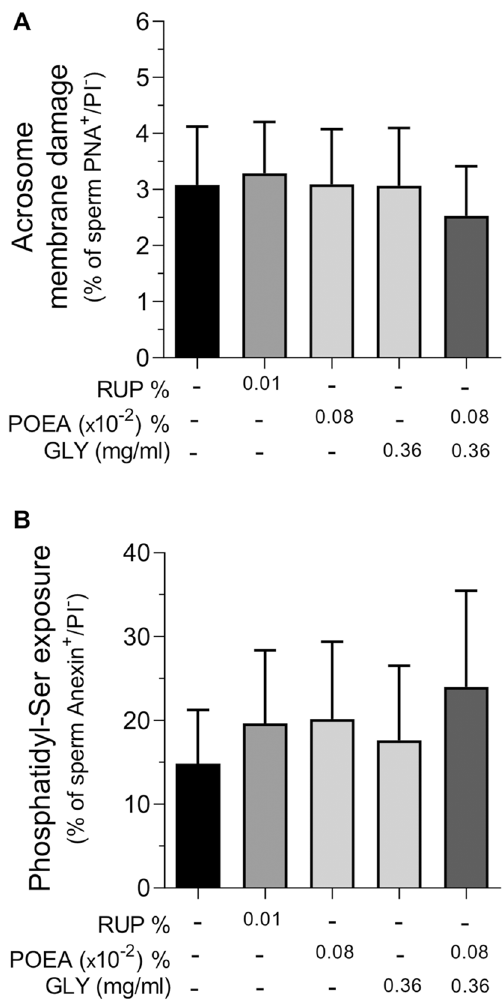
Figure 4. Effects of Roundup Ultra Plus (RUP), glyphosate (GLY) and surfactant polyoxyethylene tallow amine (POEA) on acrosome membrane damage ( A ) and phosphatidyl-serine exposure in the plasma membrane ( B ) in human spermatozoa. Spermatozoa were incubated in BWW for 1 h at 37 °C, 5% CO 2 , in the absence or presence of indicated concentrations of RUP, POEA, GLY or POEA in combination with GLY. The results were expressed as the mean of the percentage of PNA-FITC-positive and PI-negative spermatozoa (n = 5) ( A ), and of Annexin V- FITC positive and PI-negative spermatozoa (n = 4) ( B ) ± standard error of the mean (SEM). No statistical differences were